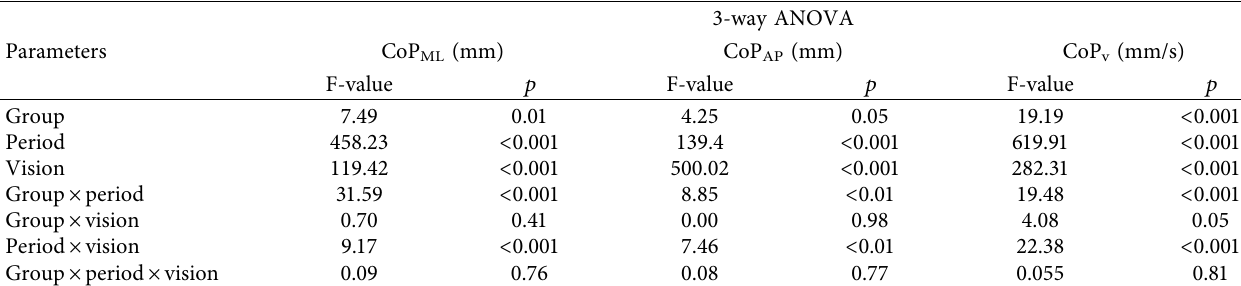
Table 3: Statistical results of the ANOVA analysis of static balance parameters (3-way